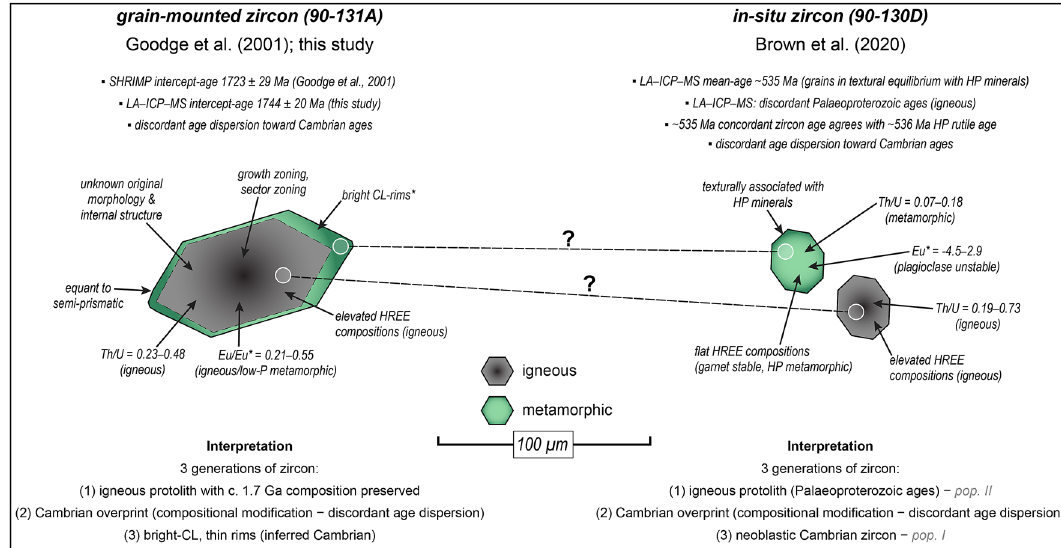
Figure 5. Schematic illustration comparing grain-mounted zircons from eclogite sample 90-131A (this study) and in-situ zircons from eclogite sample 90-130D 20 . Dashed lines connecting zircon domains infer that